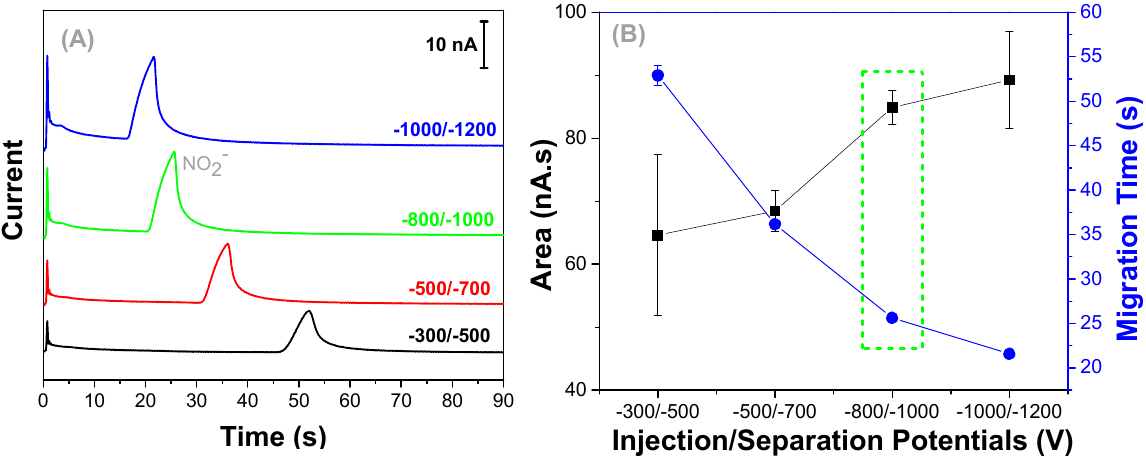
Figure 4. ( A ) Electropherograms showing the separation and detection of nitrite (50 μ mol L − 1 ) under different injection/separation voltages. ( B ) Peak area and migration time versus injection/separation potentials. Experimental conditions are given in Figure 3.